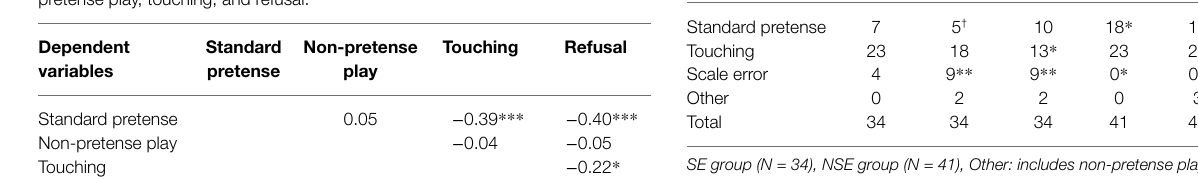
Standard Non-pretense pretense play